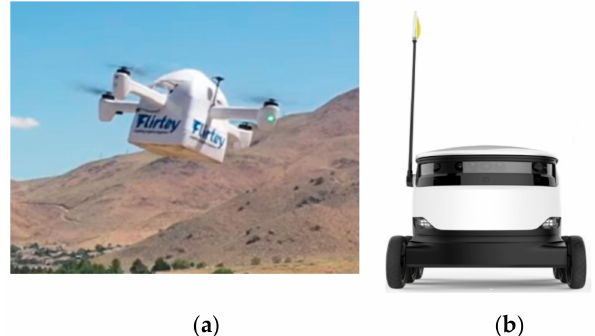
Figure 17. Outdoor delivery robots (ground based and aerial systems). ( a ) Flirtey drone robot for Table 2. Comparison of various medical robots and their